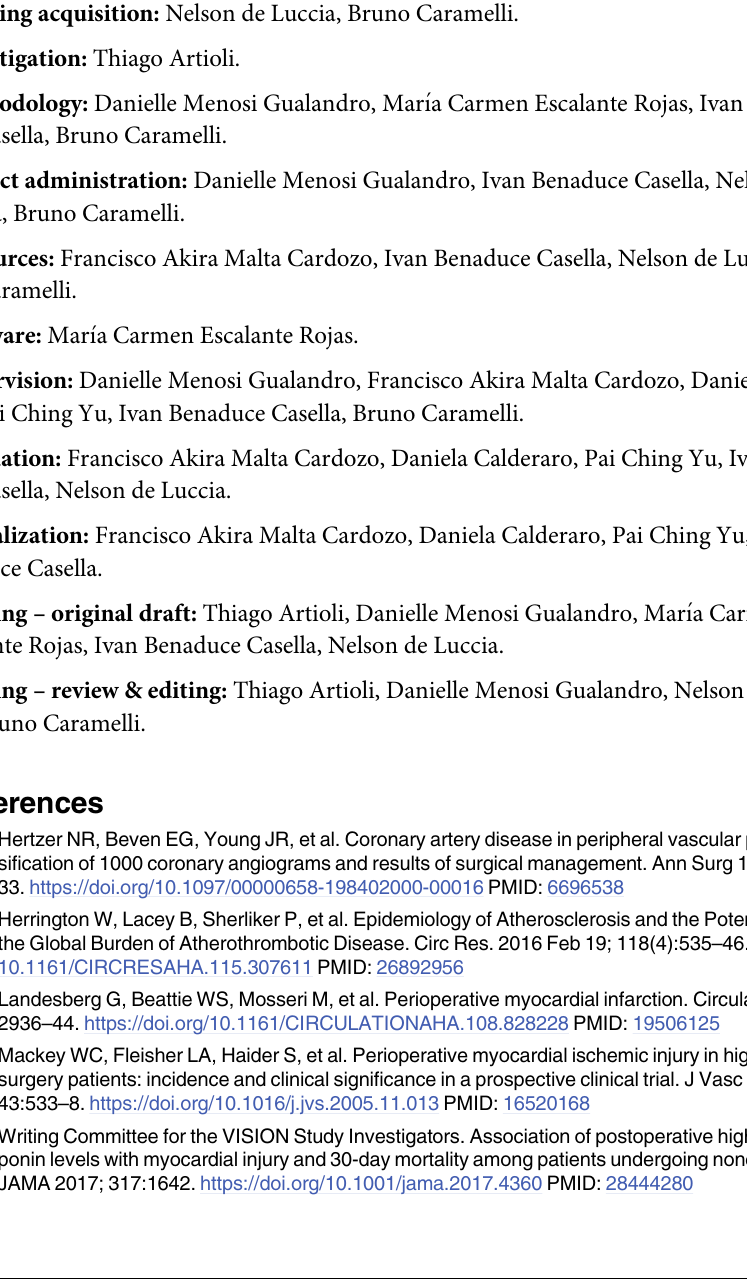
S1 Table. STROBE statement—Checklist of items that should be included in reports of cohort